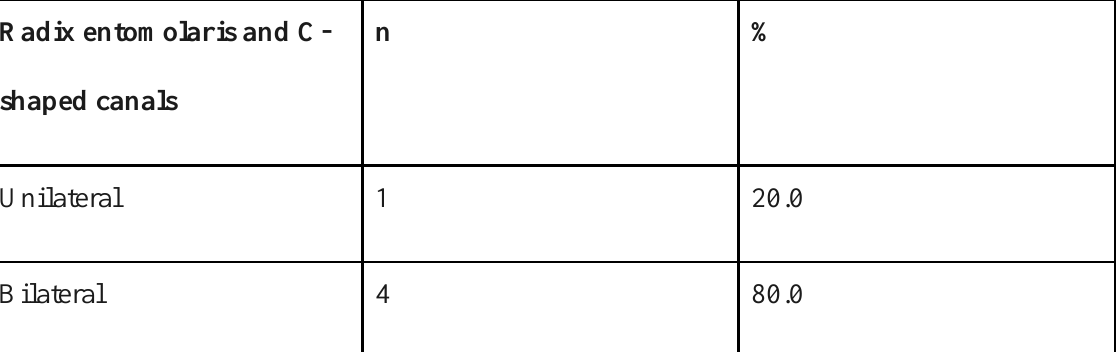
Prevalence of coexistence of radix entomolaris in mandibular first molars and C - shaped canals in mandibular second molars in pa�ents in terms of lateralisa�on